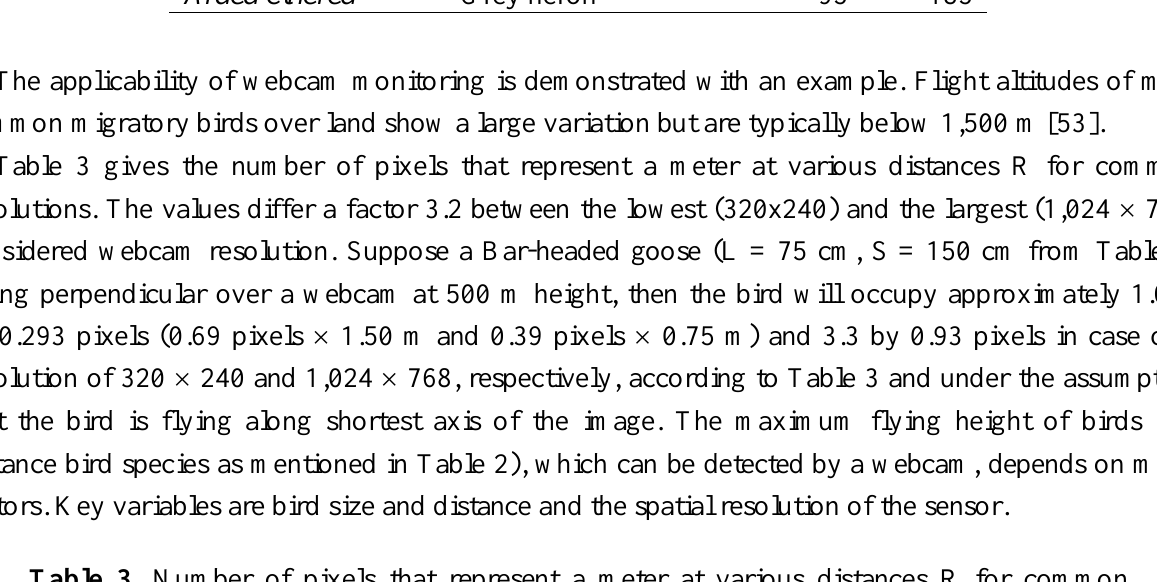
Table 3. Number of pixels that represent a meter at various distances R for common resolutions: 320 × 240, 640 × 480, 800 × 600 and 1,024 × 768 pixels. The horizontal and vertical length in meters covered by the recording or image at a distance R is given by width and height,